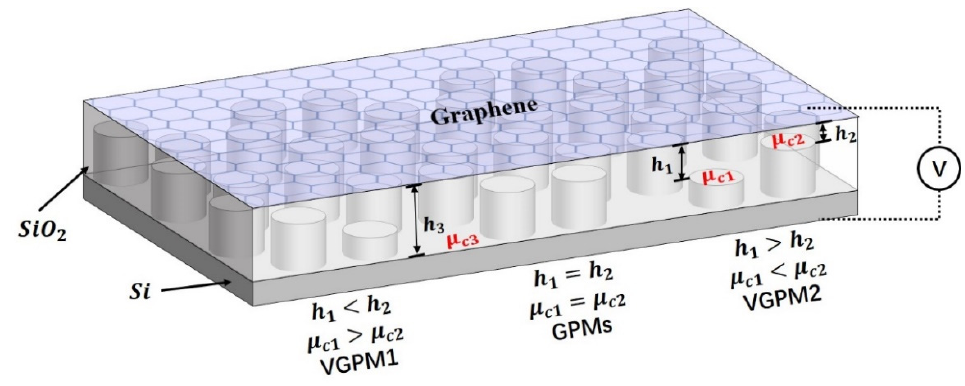
Figure 1. Schematic of valley graphene plasmonic metamaterials (VGPMs).